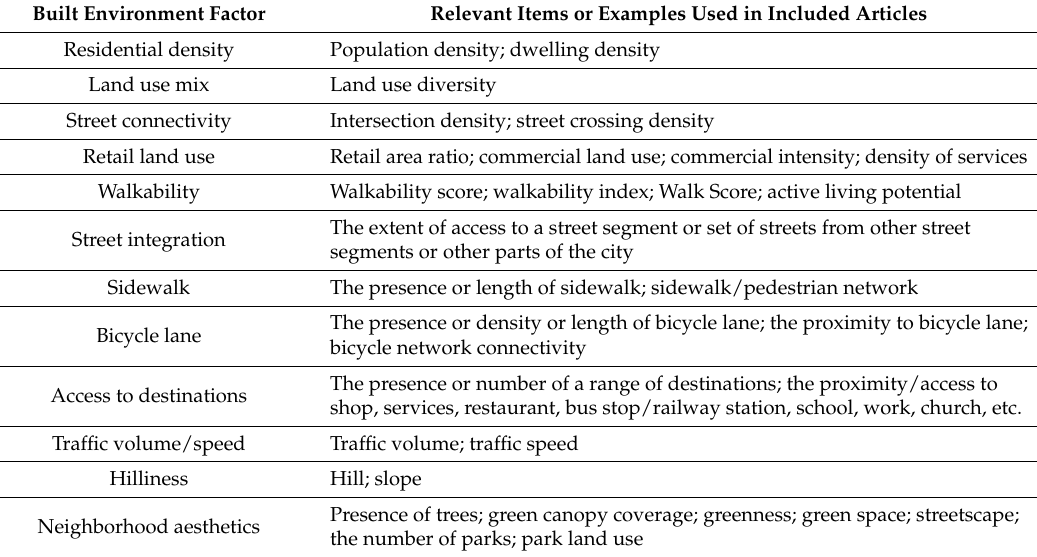
Table 1. Summary of selected built environment factors.